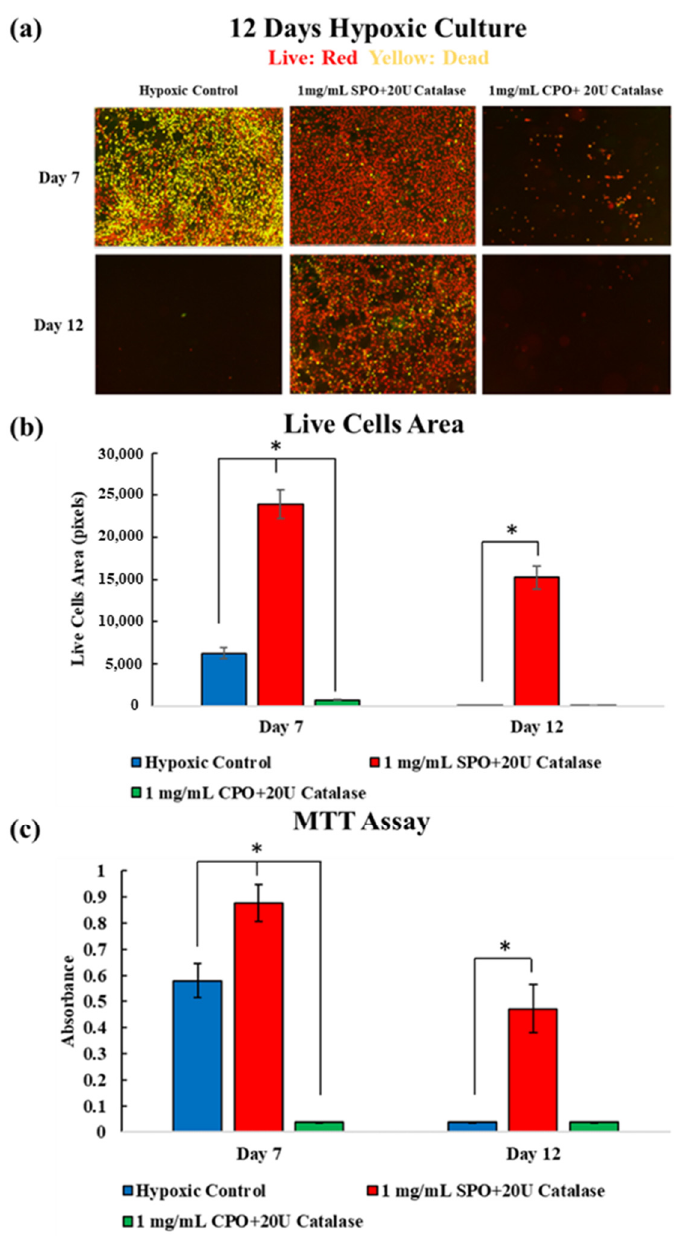
Figure 3. ( a ) Live–dead staining of C2C12 cells containing 1 mg/mL SPO/20 U catalase and 1 mg/mL CPO/20 U catalase after culturing under hypoxic conditions (0.1% O 2 ) for 7 and 12 days. Red indicates live cells and yellow indicates dead cells. ( b ) Live–dead area of live cells calculated from the area occupied with red dyed cells indicated that 1 mg/mL SPO + 20 U catalase maintained the highest viability levels up to 12 days. ( c ) MTT assay results from the different compositions after culturing under hypoxic conditions for 7 and 12 days corroborated the live–dead